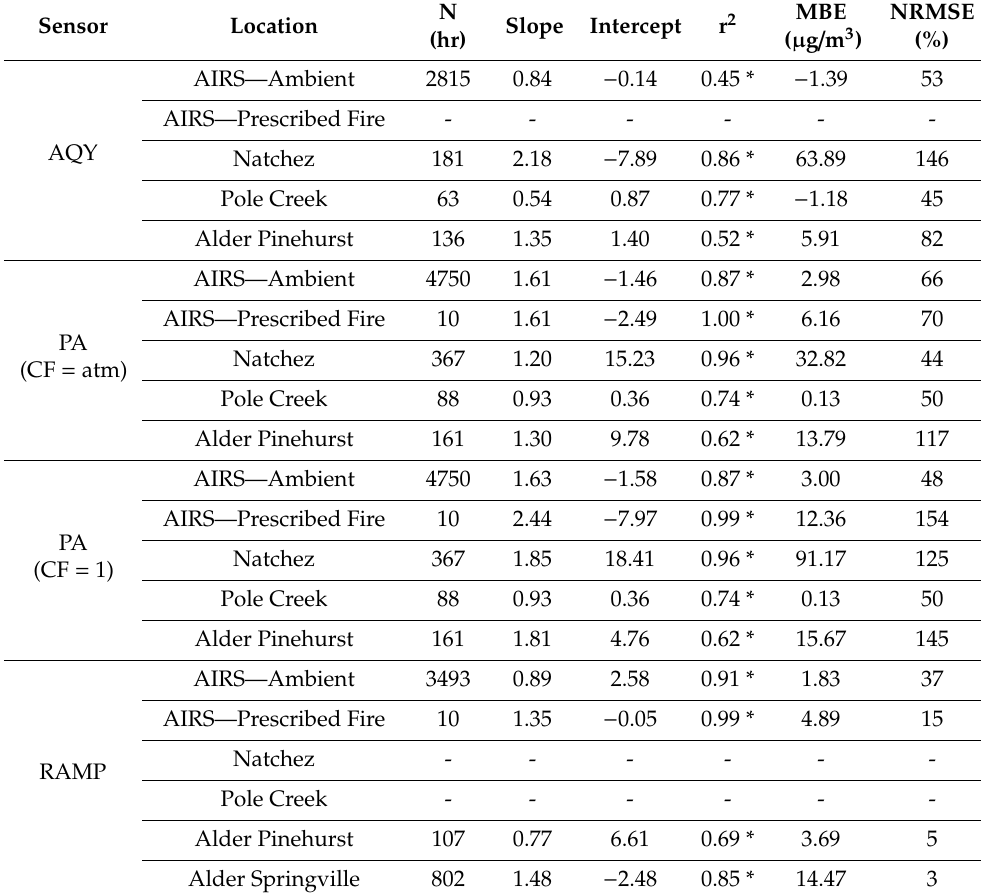
Table 5. Comparison statistics and linear regression parameters a for each data